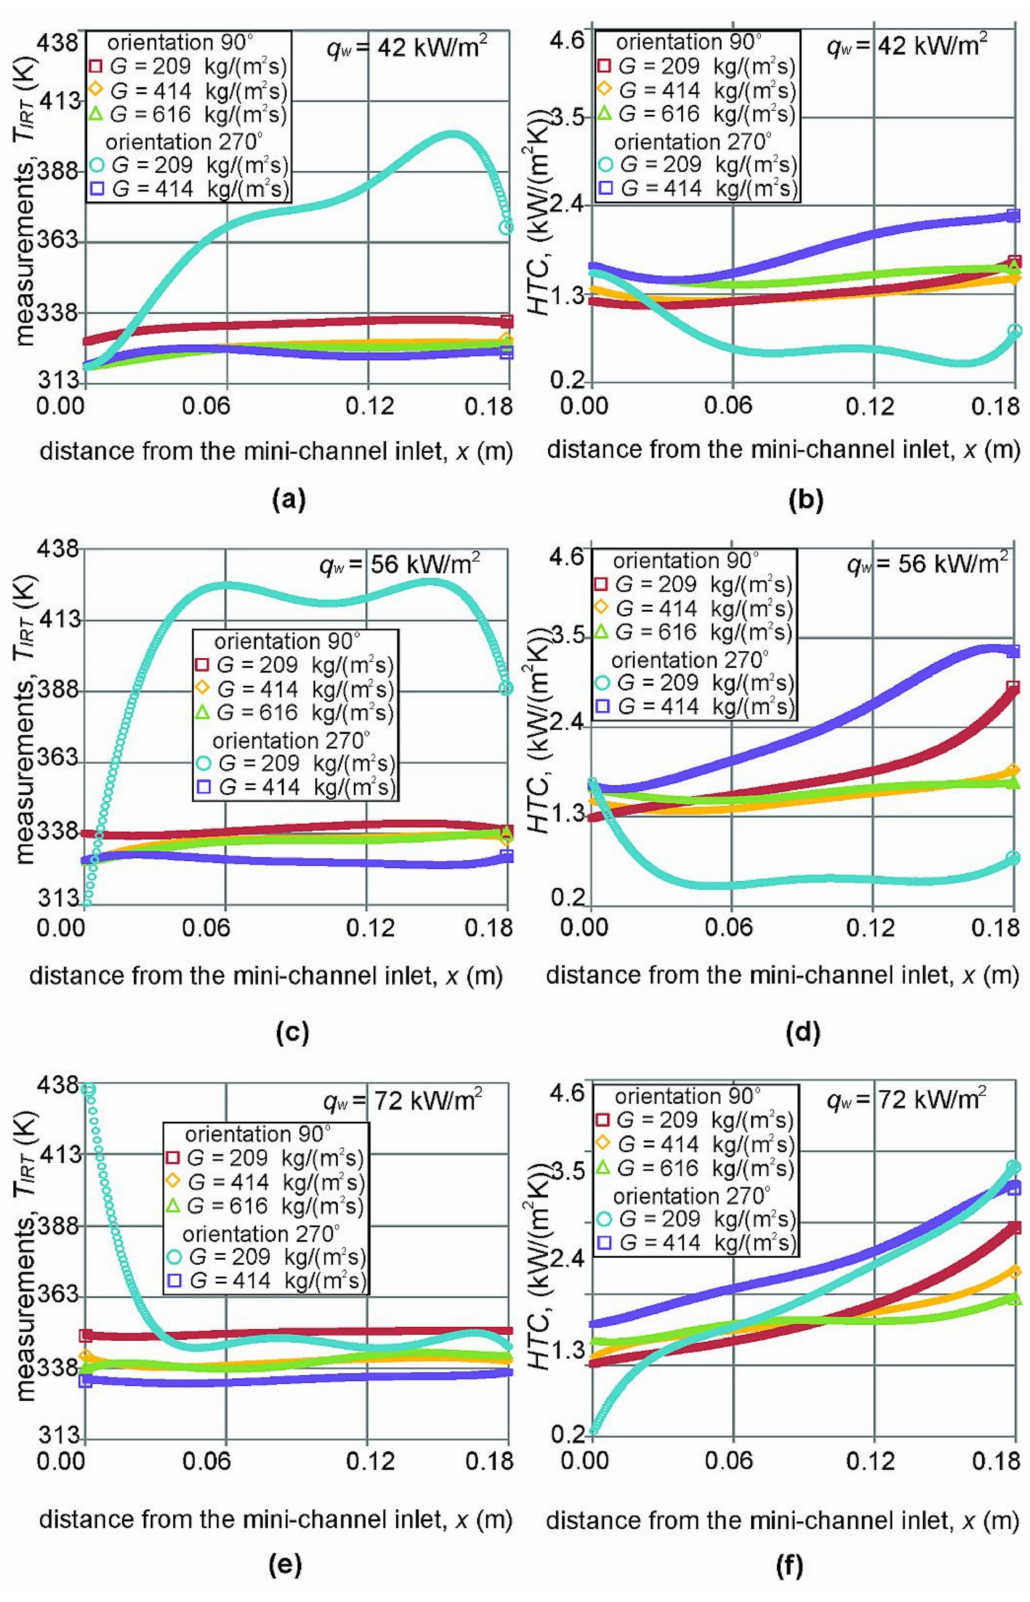
Figure 7. Plate temperature measurements using the IR camera ( a , c , e ) and heat transfer coefficient ( b , d , f ), both vs. distance from the mini-channel inlet; subcooled boiling region; various mass fluxes; two vertical channel orientations (90 ◦ and 270 ◦ ); smooth heated plate; HFE-649; L IRT = 180